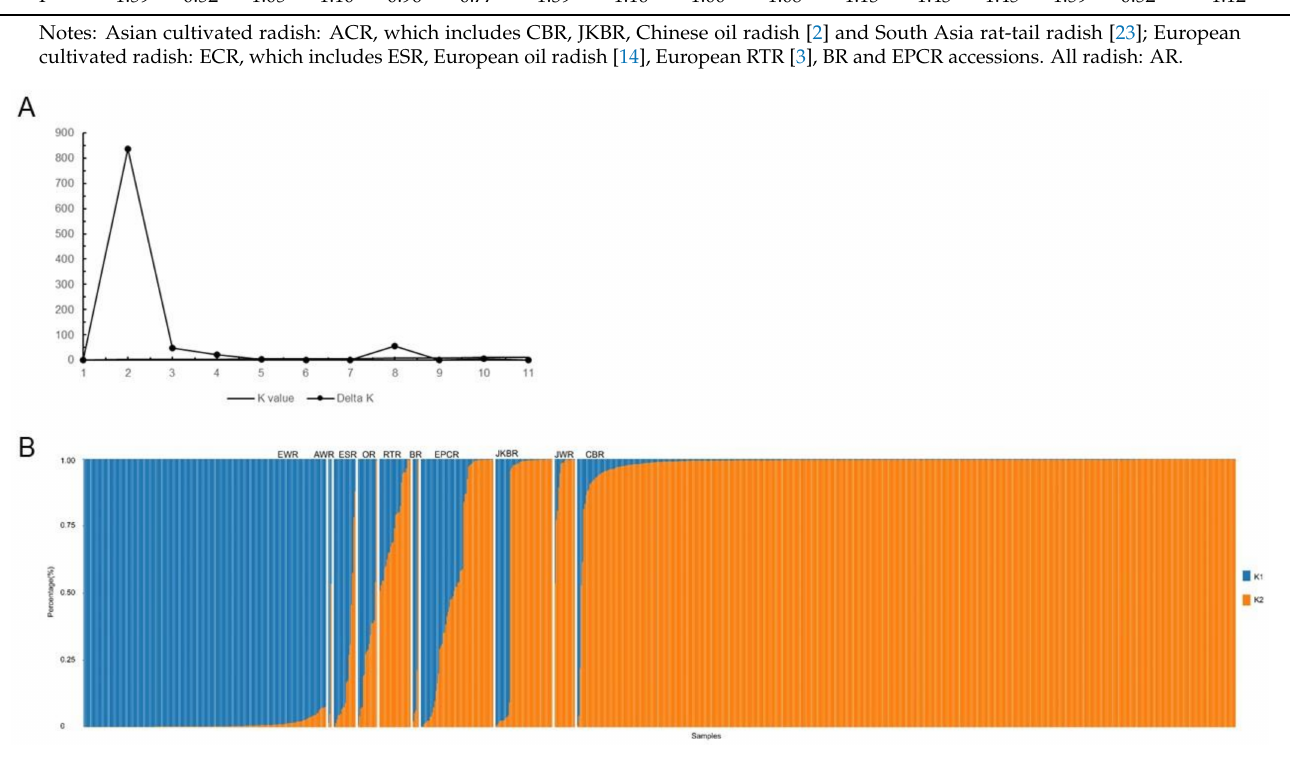
Figure 1. Population structure of 939 radish accessions. ( A ) Optimal K value for population structure analysis (K = 2). ( B ) Population structure (K = 2) of all materials. The different colors represent the probability of each accession having a different genetic background. Orange represents the cultivated radish, and blue represents the wild